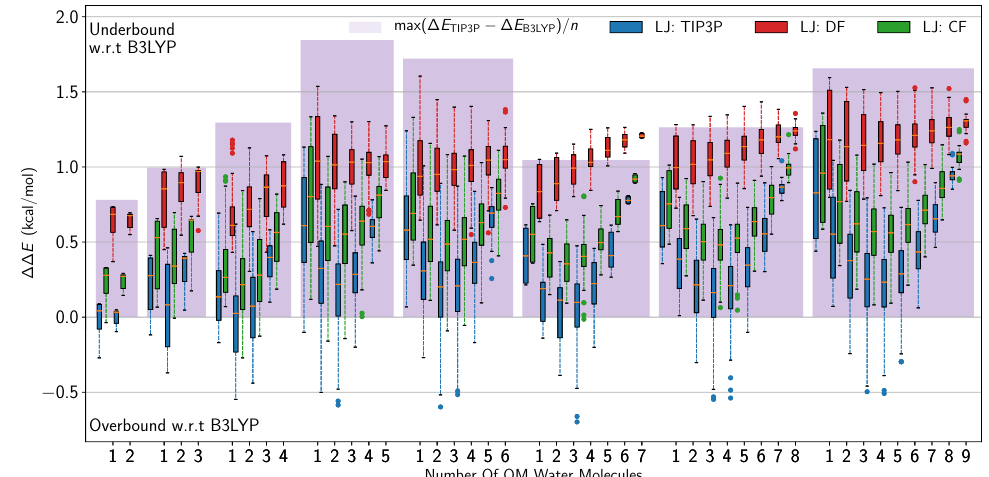
Figure 3. Boxplot of the di ff erence in interaction energies with respect to the pure B3LYP results. The horizontal axis is firstly divided divided into eight subsets based on the total number of molecules in each size of water cluster, and then further divided into subsets defined by how many of the total amount of molecules are in the QM subsystem. Each box represents the distribution of interaction energy di ff erences from all possible QM / MM combinations with that number of QM molecules. The boxes spans 50% (the IQR) of the distribution of energy di ff erences, while the whiskers represent ± 1.5 IQR. The three datasets are produced using the three di ff erent sets of LJ parameters: The original TIP3P parameters (blue), the dimer fit (DF) parameters (red), and the cluster fit (CF) parameters (green). The blue patches behind the box plots show the maximum di ff erence between the two pure